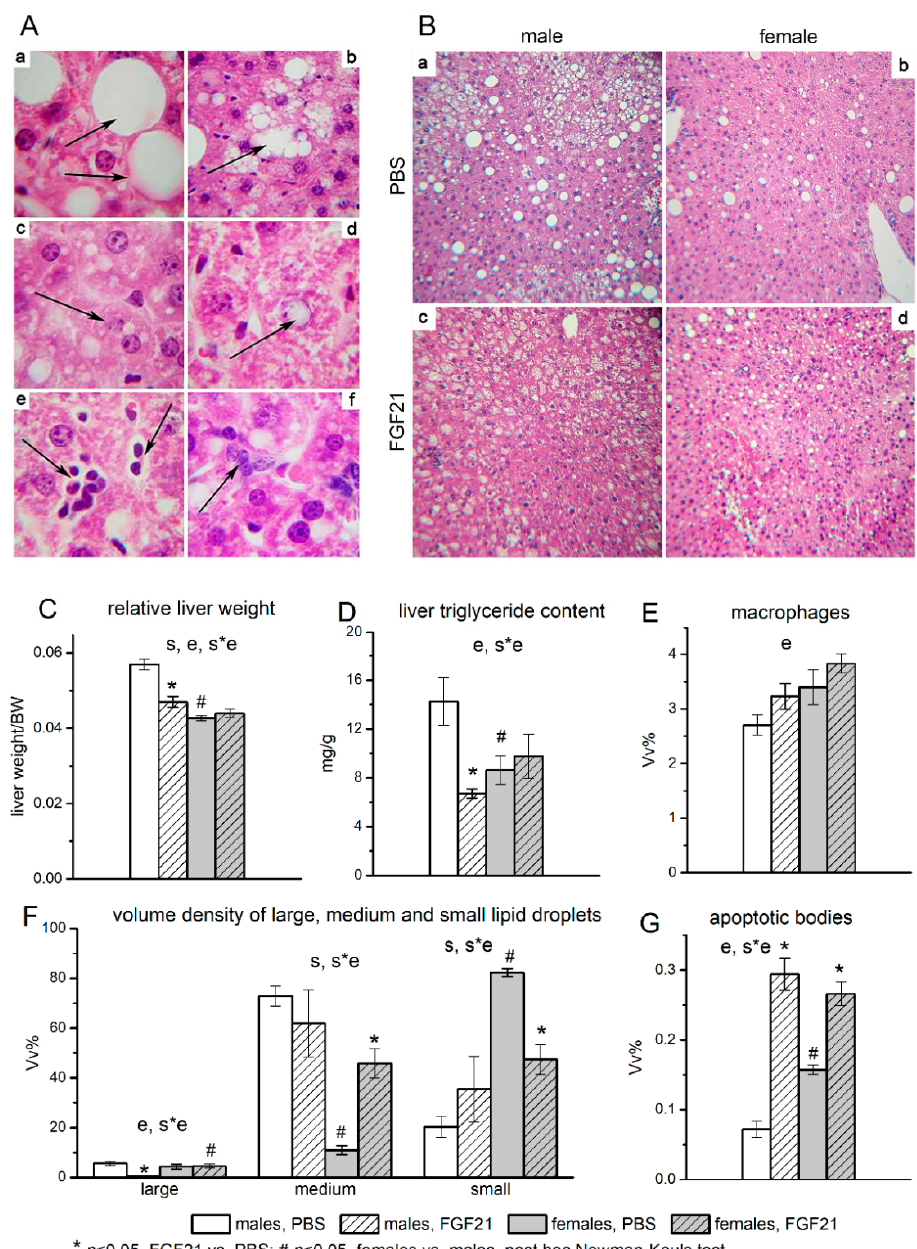
Figure 3. Liver structure ( A ), and influence of FGF21 administration on lipid accumulation in hepatocytes ( B ), liver index ( C ), fat content ( D ), macrophage infiltration ( E ), sizes of lipid droplets in hepatocytes ( F ), and number of apoptotic bodies ( G ) in obese A y male and female mice. A- Liver structure of C57BL/6J- A y mice. Staining with hematoxylin and eosin. Magnification × 1000. ( a ) Hepatocytes with large-size lipid inclusions occupying the entire volume of the cytoplasm (arrows). ( b ) Hepatocytes with medium-size lipid inclusions. Individual lipid droplets are visualized (arrow). ( c ) Hepatocytes with small-size lipid inclusions. Individual small lipid droplets are visible (arrow). ( d ) Lipid droplet in the hepatocyte nucleus (arrow). ( e ) Apoptotic bodies in the liver parenchyma (arrows). ( f ) Accumulation of macrophages in the liver parenchyma (arrow). B—Sex differences in lipid accumulation in the liver of C57BL/6J- A y mice. Mice were administered FGF21 for 7